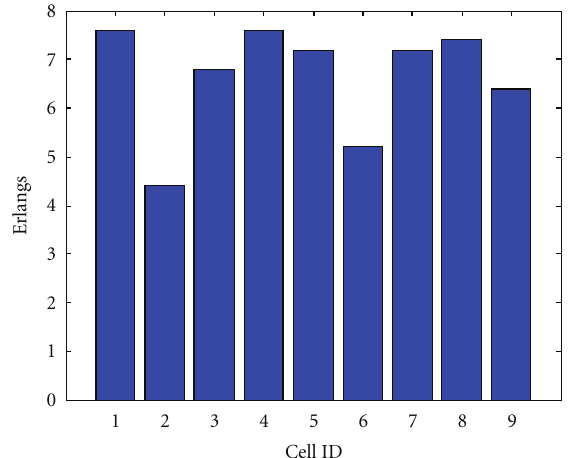
Figure 15: Load handled by the femtocells in fixed power (no. of FBSs = 9).